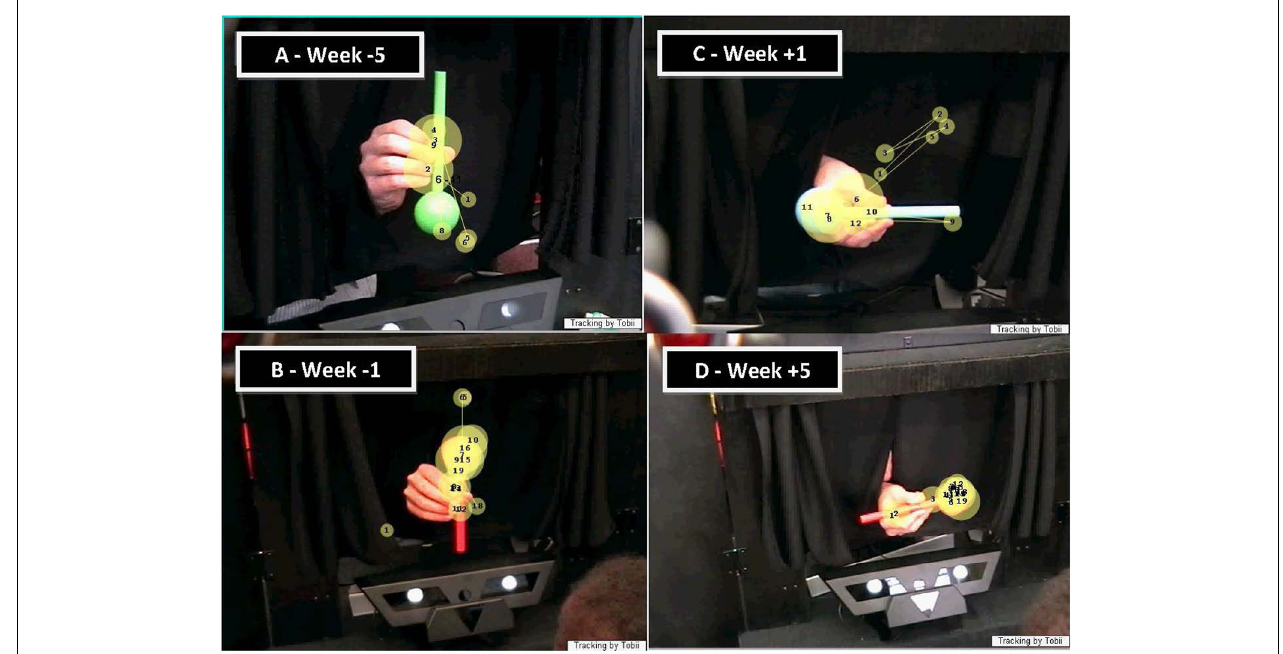
FIGURE 2 | Illustration of the developmental progression of infant MC’s looking patterns directed at the drumstick object. The object is displayed in all four orientations. The numbered dots on the image indicate the points of fixations, their sizes indicate the duration of the fixations, and the lines correspond to saccades. (A) example of object-directed looking pattern